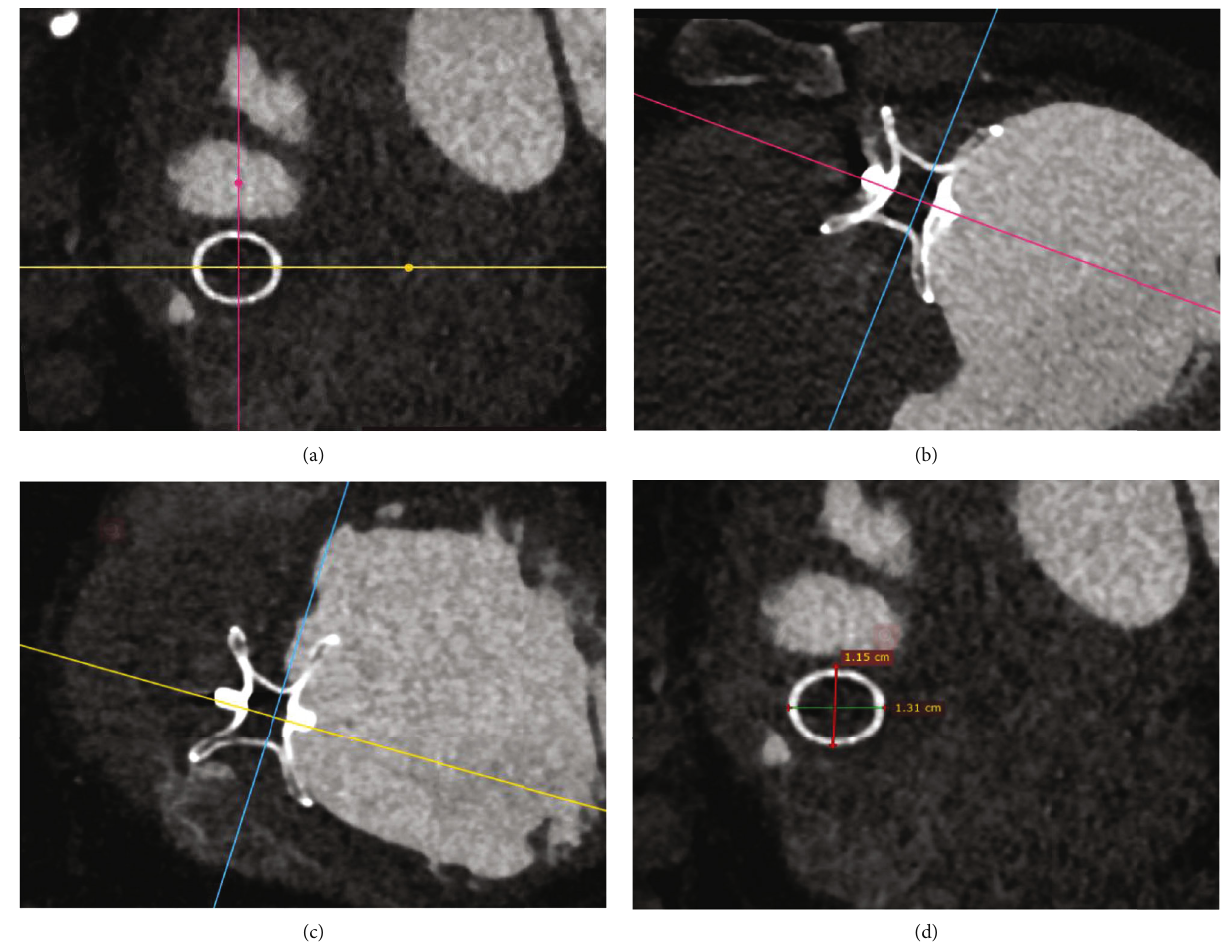
Figure 1: Measurement of POD by 3D-MPR mode of cardiac CT. (a) The fi nest part of waist in the short-axis section of occluder. (b, c) The long-axis sections of occluder perpendicular to each other. (d) The measurement method of POD, which is the average value of diameter in two vertical directions of occluder in